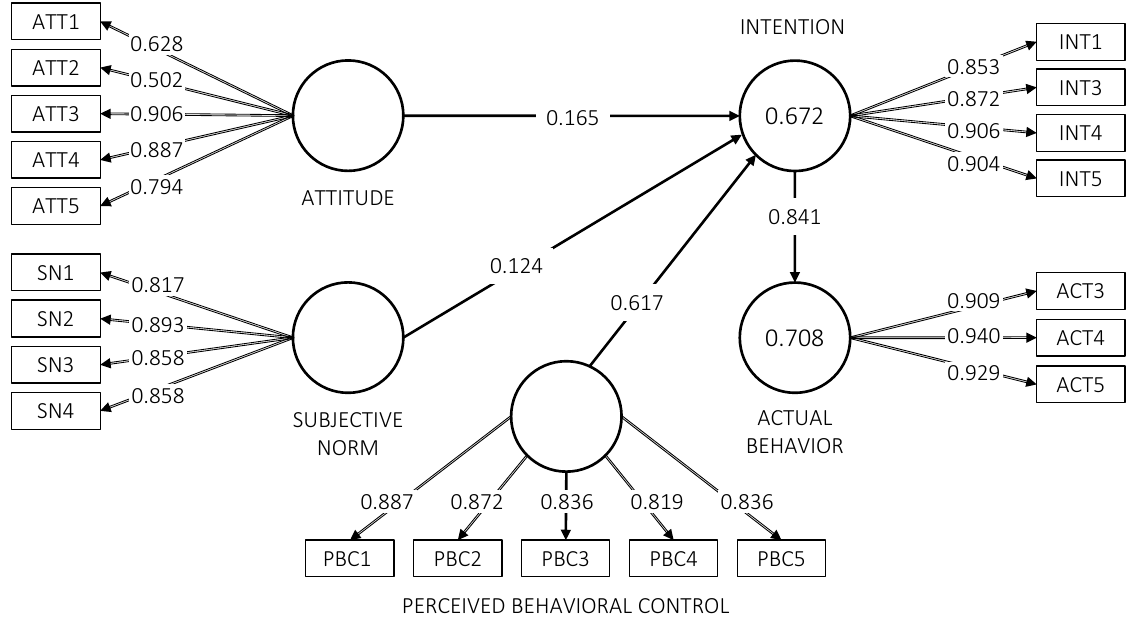
Figure 2. Path coefficients